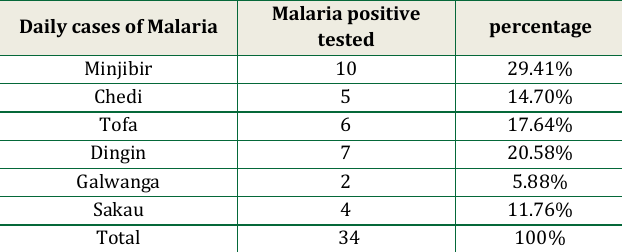
Table 1: Daily Average analysis of the prevalence of the Malaria